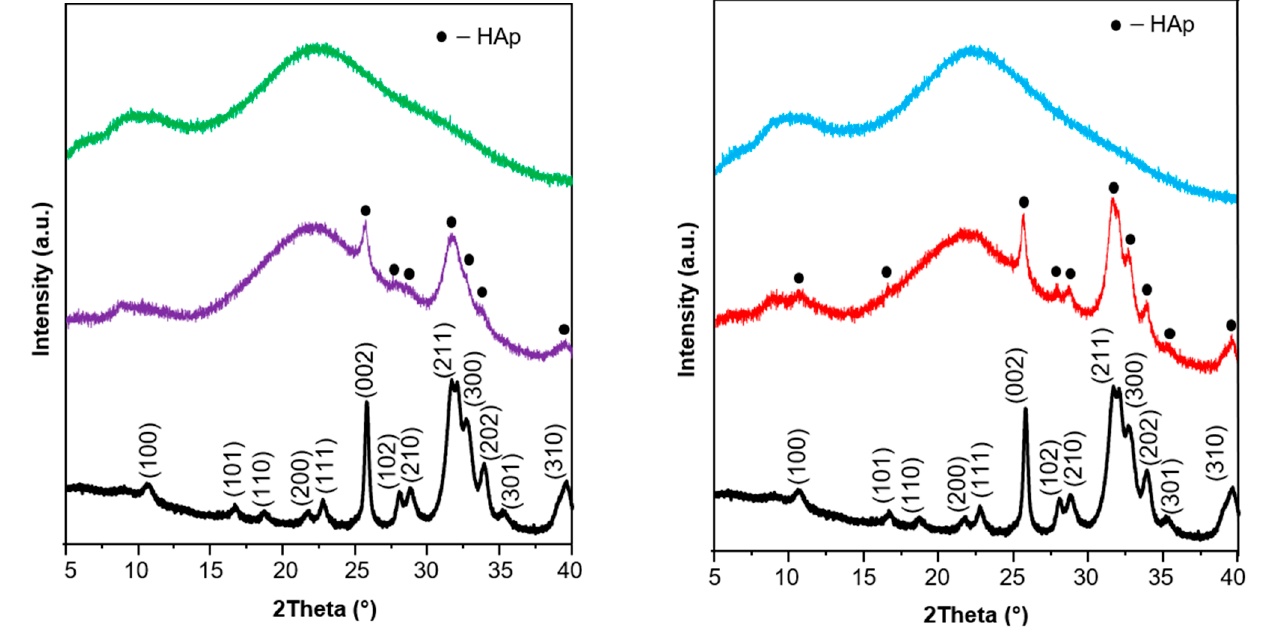
Figure 6. ( a ) The XRD patterns of synthesized bioglass before (green) and after (violet) 7 days of incubation in SBF together with a hydroxyapatite reference sample (black); ( b ) The XRD patterns of pellets before (blue) and after (red) 28 days of incubation in SBF together with a hydroxyapatite reference sample (black).